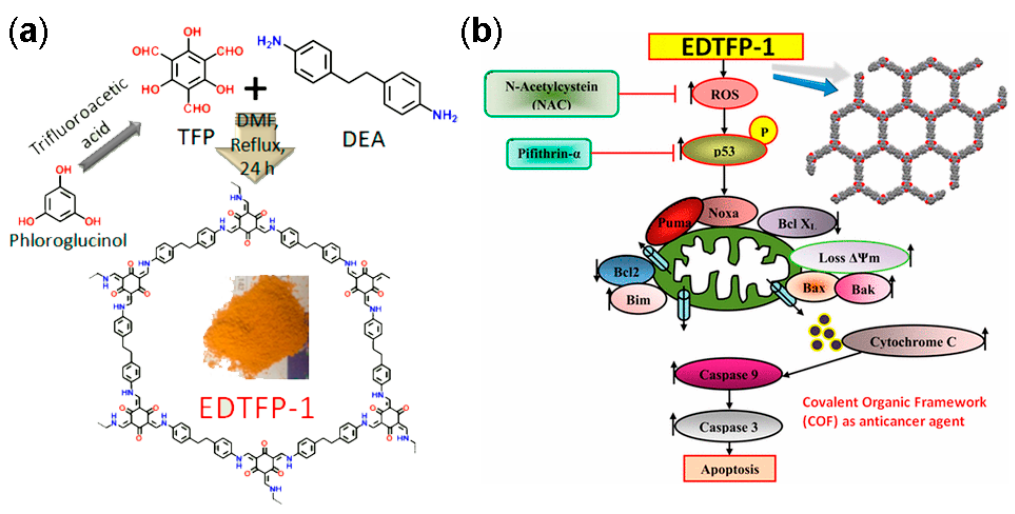
Figure 12. Schematic representations of the preparation of EDTFP-1 ( a ) and its induced apoptotic pathway ( b ). Reproduced with permission from [328]. Copyright American Chemical Society, 2017.